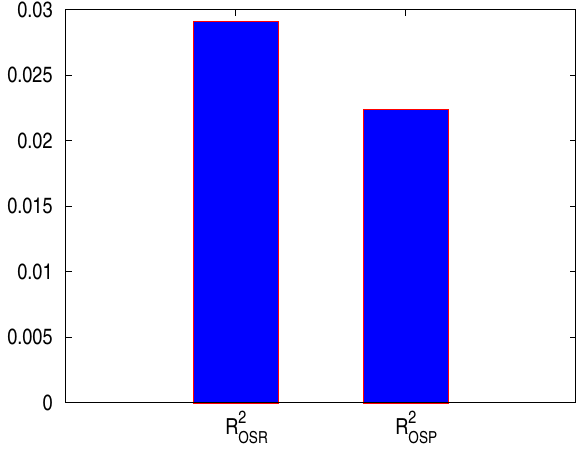
Figure 4. The R 2 , and R 2 of S&P 500 monthly prices from December 2011 to November OSP OSR